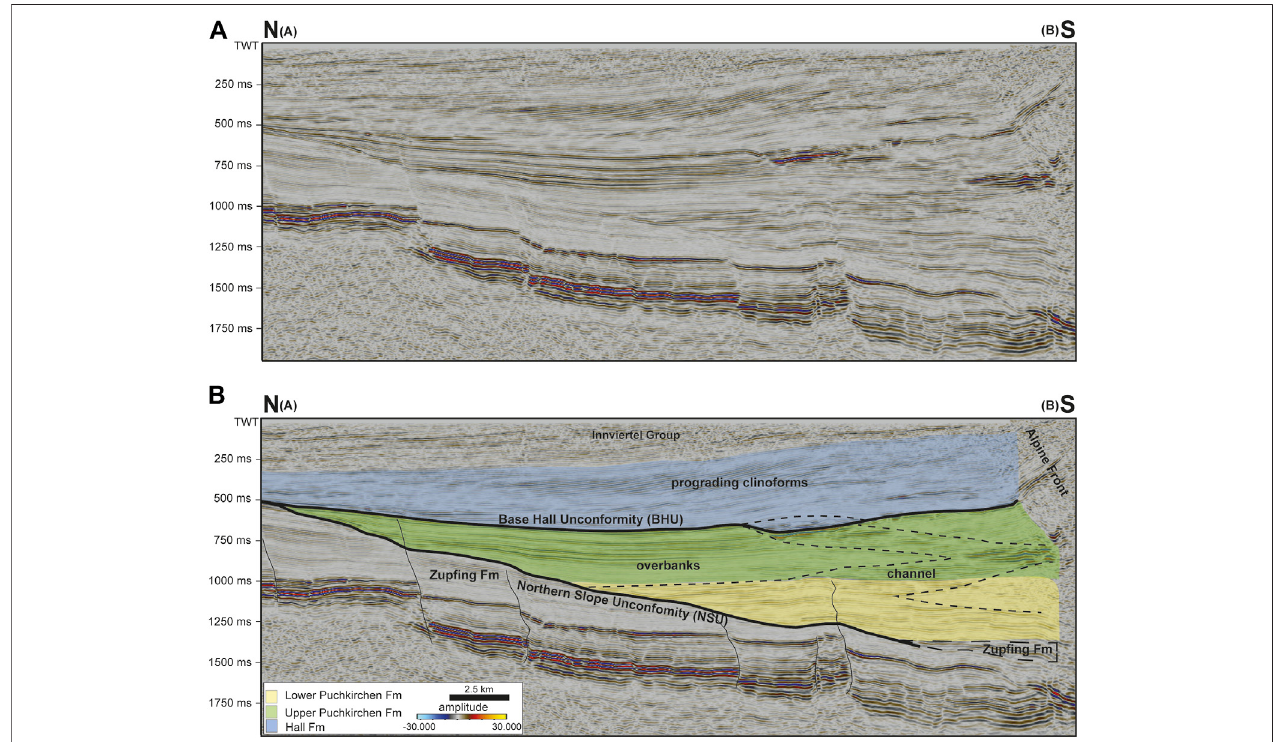
FIGURE 4 | Seismic re fl ection cross-section (N – S) through the Upper Austrian NAFB (see Figure 2 for position), (A) uninterpreted, (B) interpreted cross-section. Notethelateralmigrationofthechannelintime.Tothenorththechannelisbordered bywide( ≤ 15 km)overbanksintowhichWellHwasdrilled.Tothesouththebasinis bounded by the steep, tectonically active southern slope from where submarine fans propagated into the basin. In the Hall Formation, the sediment-transport direction changed from an eastward-directed channel-dominated system to a northward-directed prodelta clinoform-dominated system. Note the BHU, the NSU and the prograding clinoforms in the Hall Formation. The stratigraphic scheme is taken from Hülscher et al. (2019).